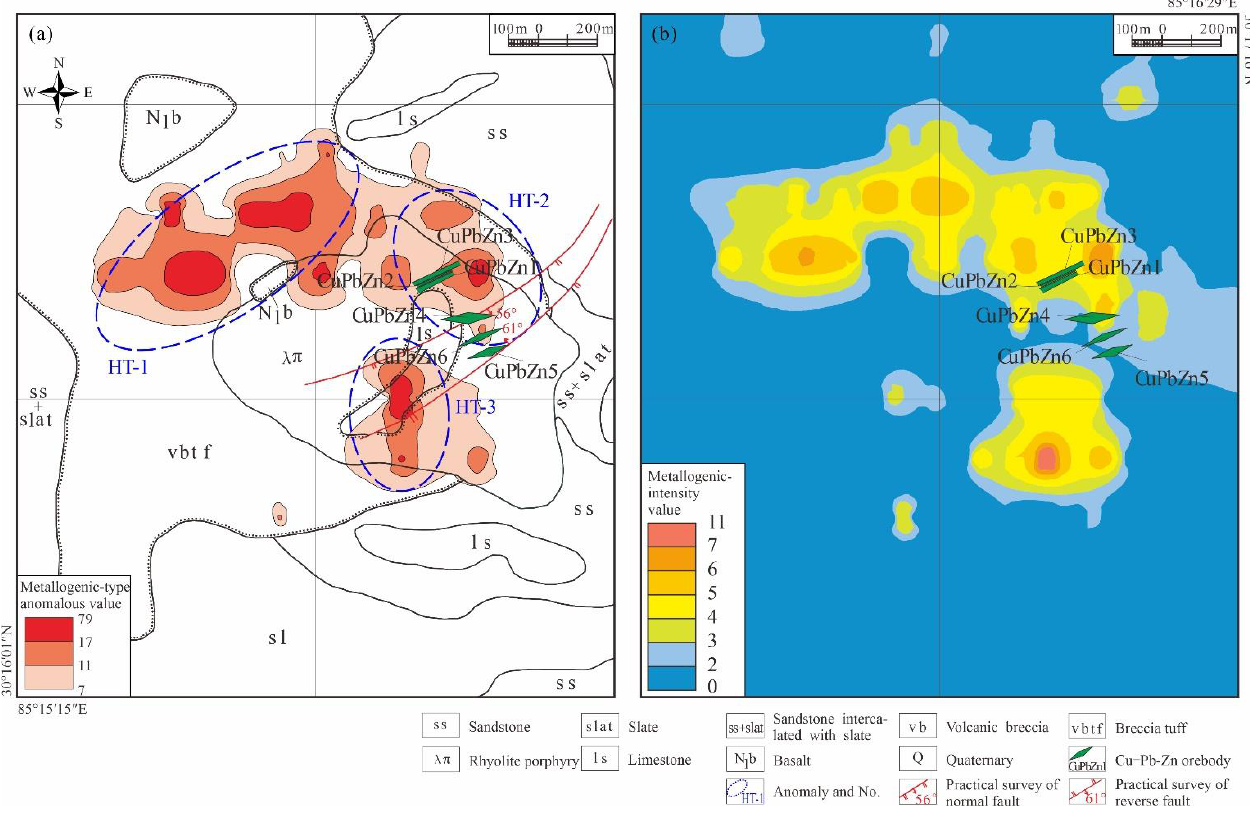
Figure 10. ( a ) Metallogenic-type (Pb-Zn-Cu-As-Sn-Mn) anomalous map in Central Nuocang. ( b ) Metallogenic-intensity (all elements tested using a pXRF) map in Central